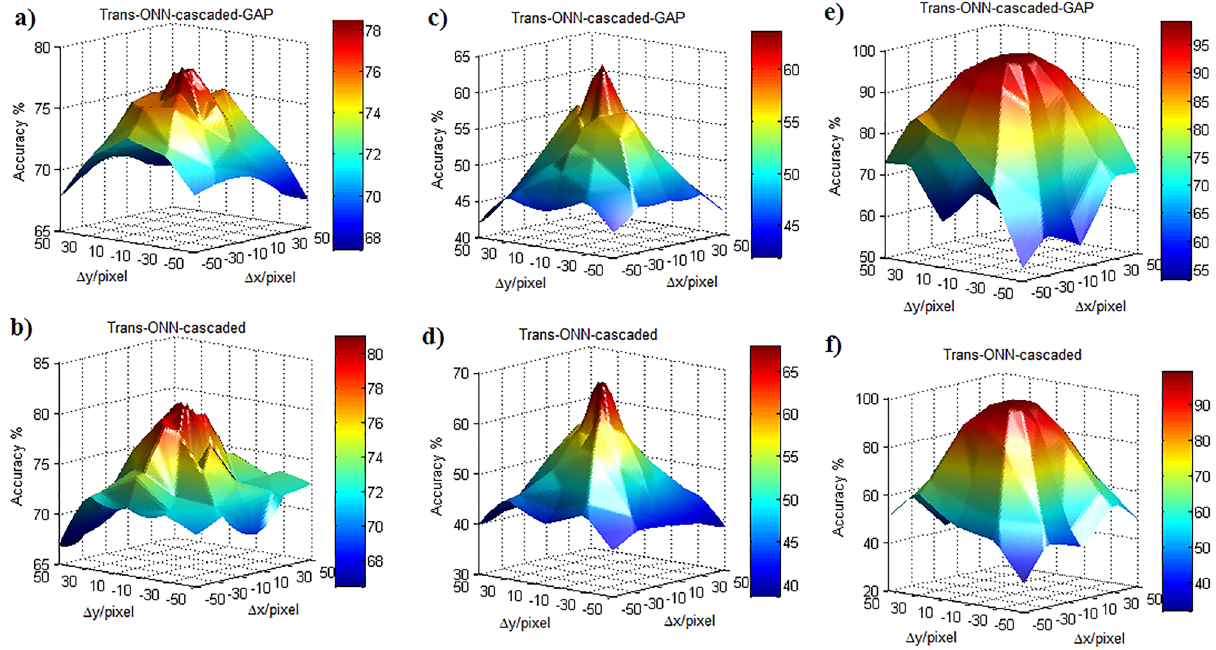
Figure 13. Classification accuracy of translated test images in both x and y directions, for ( a ) Trans-ONN- cascaded-GAP for Kaggle Cats and Dogs dataset, ( b ) Trans-ONN-cascaded networks for Kaggle Cats and Dogs dataset, ( c ) Trans-ONN-cascaded-GAP for CIFAR-10 dataset, ( d ) Trans-ONN-cascaded networks for CIFAR- 10 dataset, ( e ) Trans-ONN-cascaded-GAP for MNIST dataset, ( f ) Trans-ONN-cascaded networks for MNIST dataset.